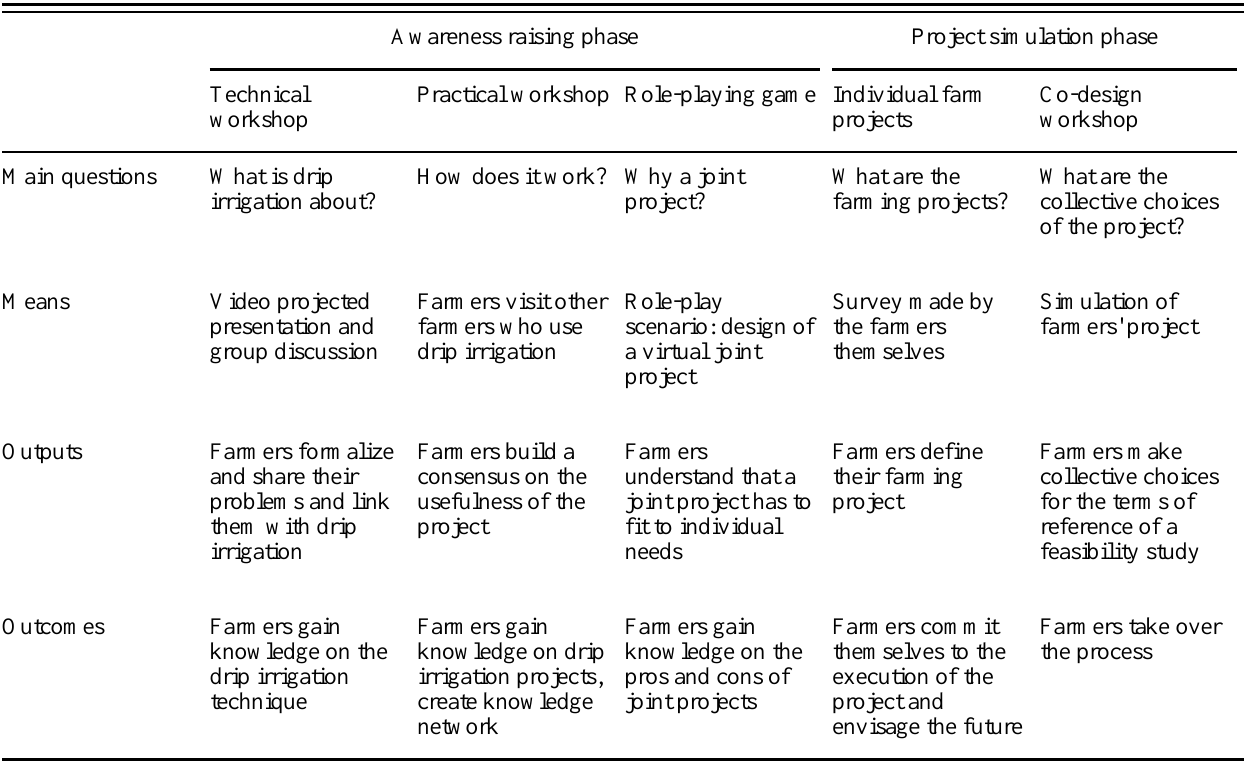
Table 1 . The approach adopted in this